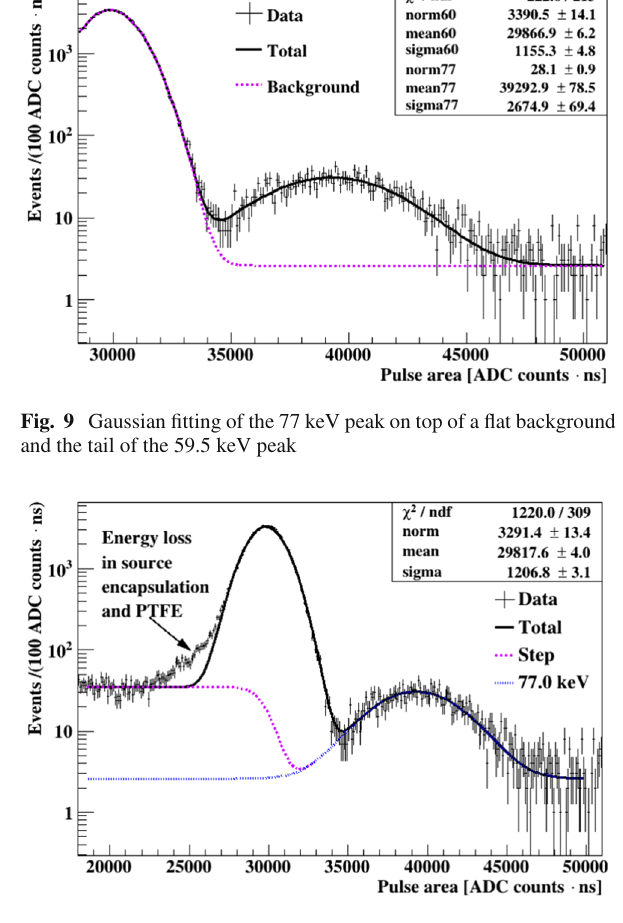
used to fit the 59.5 keV peak: